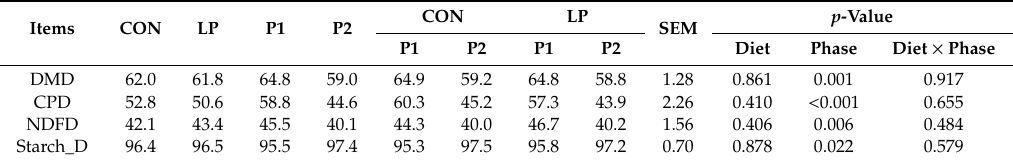
Table 3. E ff ect of high protein (CON) and low protein (LP) diets, during growing (P1) and finishing (P2) phases, on the digestibility of dry matter, crude protein, neutral detergent fiber and starch (DMD, CPD, NDFD and starch_D, respectively) by young Charolais beef bulls at Rovigo Province, Italy. Data are the means of 5 or 6 pens and 9 to 10 animals per